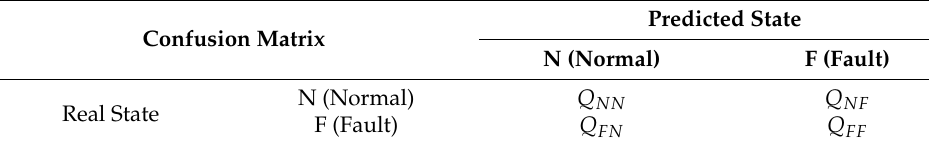
Table 1. Confusion matrix